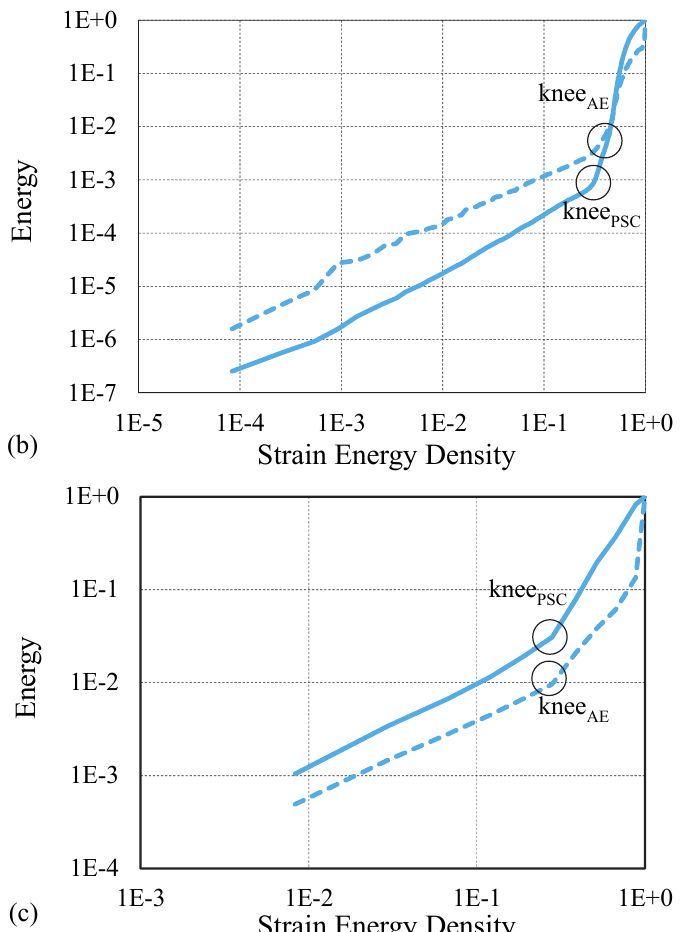
Figure 5 (con’t): The energy calculated by both PSC and AE techniques versus the strain energy density for a typical specimen of (b) mortar and (c)